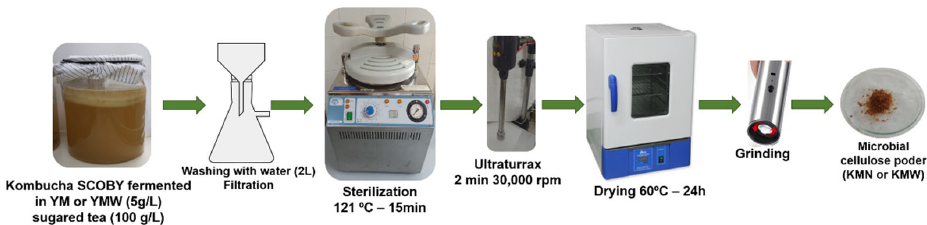
Figure 1. Schematic representation of the microbial cellulose (KMN and/or KMW) production from kombucha fermented in YM or YMW.